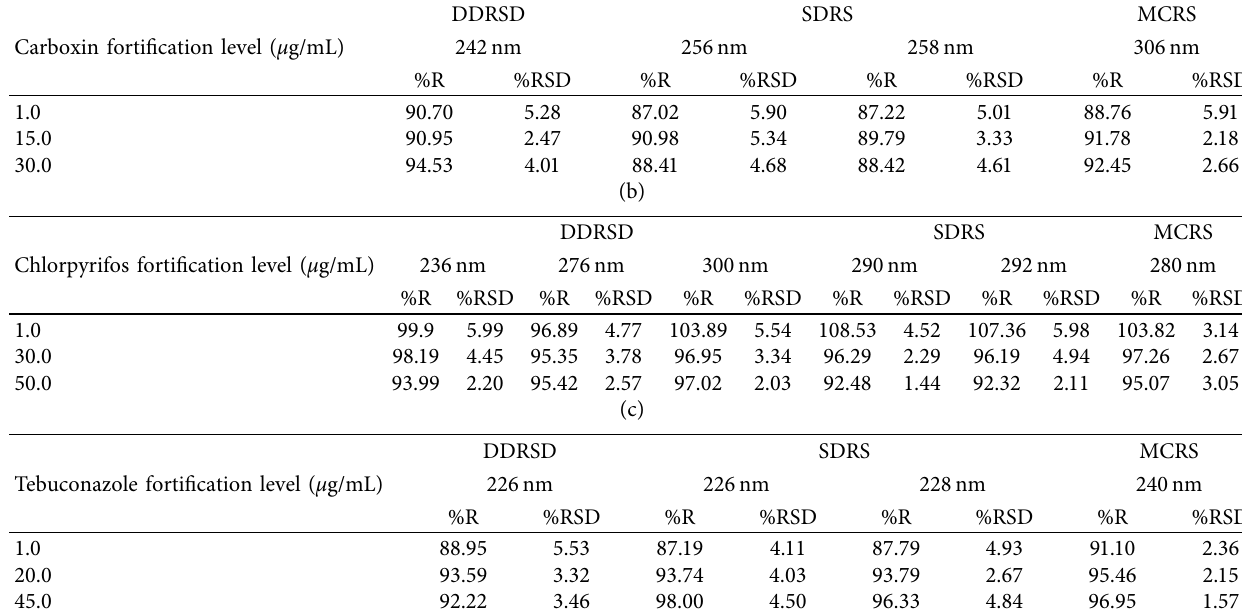
Table 3: Percentage mean recovery of carboxin, chlorpyrifos, and tebuconazole in real cabbage samples by the proposed methods.